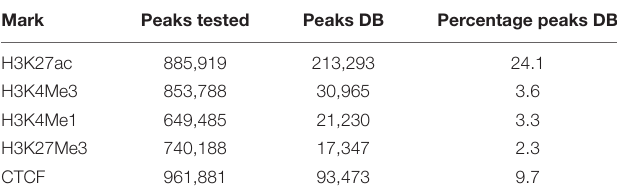
TABLE 3 | Differentially bound